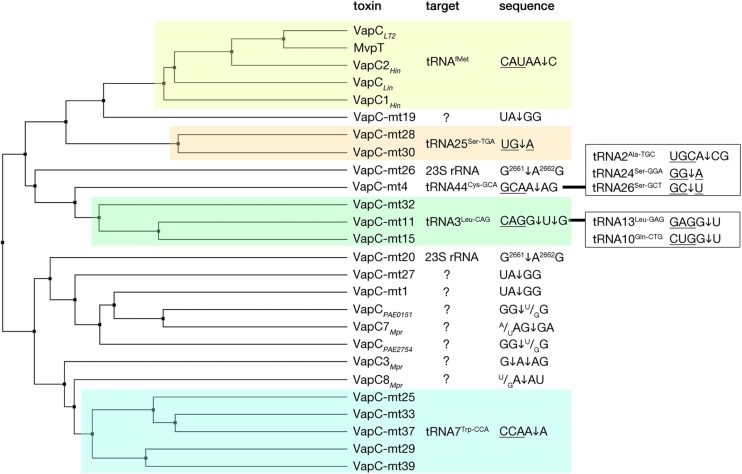
VapC toxins and their specificity of RNA cleavage. VapC protein sequences were aligned and an average distance tree was build (BLOSUM 62, JalView) (Waterhouse et al., 2009). Substrate specificity is indicated (right). Toxin cleavage position is marked by an arrow, tRNA anticodon sequence is underlined, in the case of rRNA numbers of nucleotide positions are indicated in superscript. Additional targets and sequences are marked in the boxes on the right. Subsets of toxins sharing similar target sequences are boxed with different colors. Protein identifiers and cleavage specificity were taken from: Haemophilus influenzae VapC1Hin (NP_438487.1), VapC2Hin (NP_439108.1) (Walling and Butler, 2018); Salmonella enterica VapCLT2 (NP_461950.1), Shigella flexneri MvpT (AMN61047.1) (Winther and Gerdes, 2011); Leptospira interrogans VapCLin (AAS71220.1) (Lopes et al., 2014); Mycobacterium tuberculosis VapC-mt4 (NP_215109.1) (Cruz et al., 2015; Winther et al., 2016), VapC-mt11 (NP_216077.1) (Winther et al., 2016; Cintron et al., 2019), VapC-mt15(NP_216526.1), VapC-mt25 (NP_214791.1), VapC-Mt28 (NP_215123.1), VapC-mt29 (NP_215131.1), VapC-mt30(NP_215138.1), VapC-mt32(NP_215630.1), VapC-mt33 (NP_215758.1), VapC-mt37 (NP_216619.1), VapC-mt39 (NP_217046.1) (Winther et al., 2016), VapC-mt20 (NP_217065.1), VapC-mt26 (NP_215096.1) (Winther et al., 2013, 2016), VapC-mt1 (NP_214579.1) (McKenzie et al., 2012; Sharrock et al., 2018), VapC-mt19 (NP_217064.1), VapC-mt27 (NP_215112.1) (Sharrock et al., 2018), Pyrobaculum aerophilum VapCPAE2754 (WP_011008882.1), VapCPAE0151 (WP_011007068.1) (McKenzie et al., 2012); Metallosphaera prunae VapC3Mpr (WP_012020824.1), VapC7Mpr (WP_012021162.1), VapC8Mpr (WP_012021192.1) (Mukherjee et al., 2017).